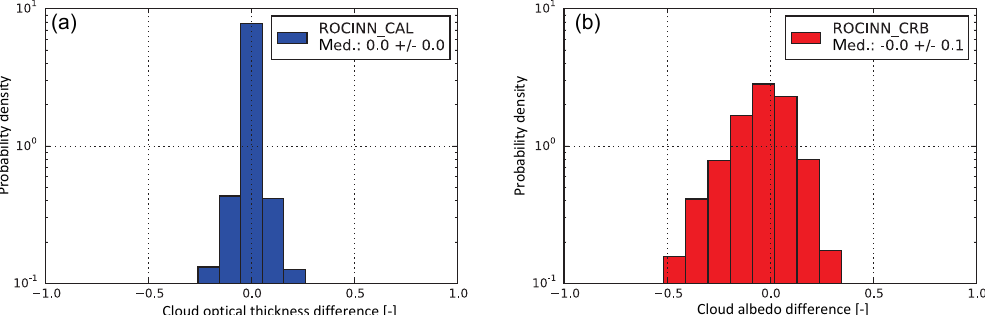
Figure 4. Histogram of the absolute differences between the simulated spectra and (a) the cloud optical thickness retrievals from ROCINN_CAL and (b) the cloud albedo retrievals from ROCINN_CRB. The retrieved cloud optical thickness varies from 2 to 50, with the cloud albedo ranging from 0 to